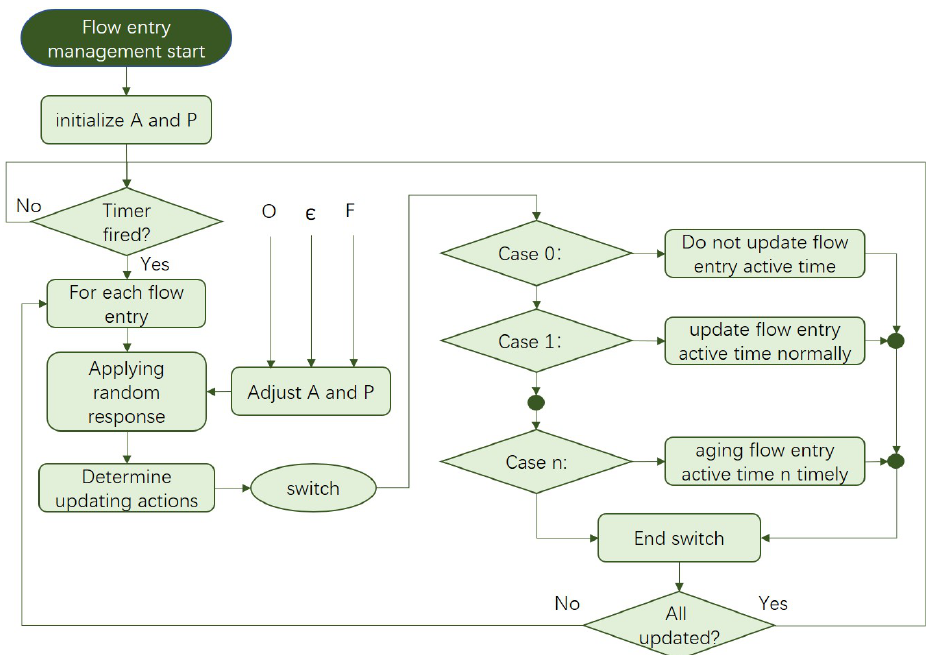
Figure 4. The flow chart of